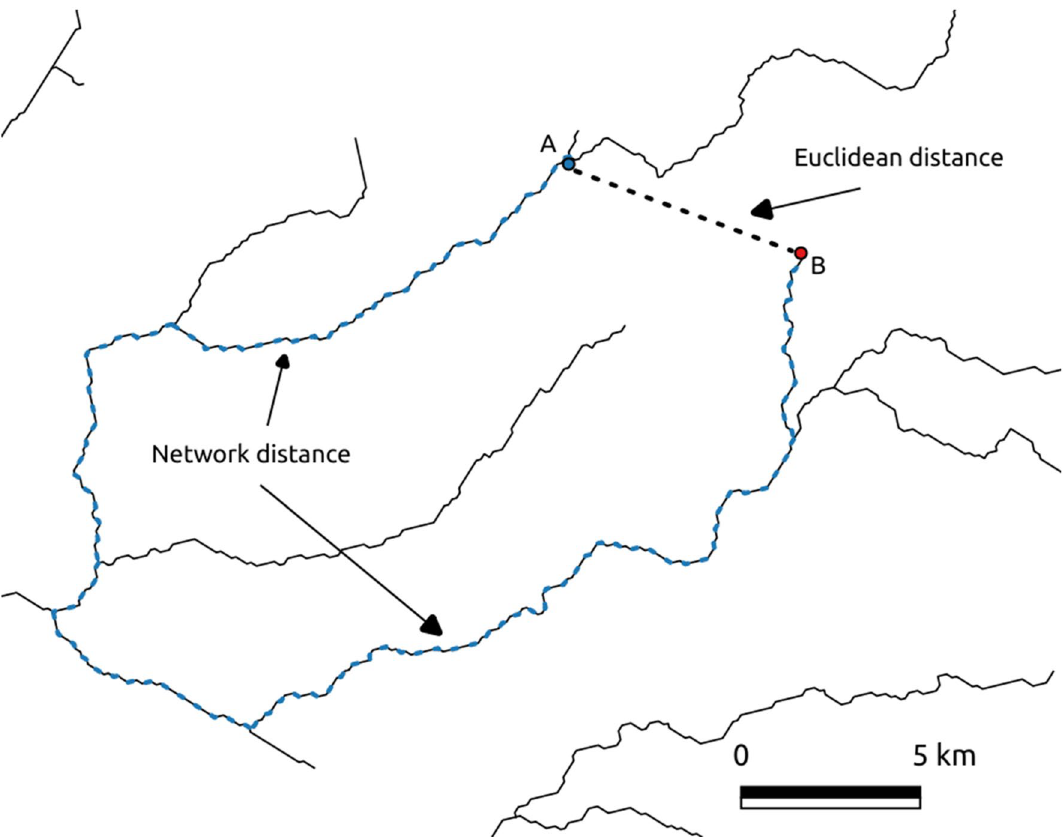
Figure 2. This figure shows two riparian vegetation samples, A and B (blue and red dot) that are separated by a large network distance (dashed blue line) and by a small Euclidean distance (dashed black